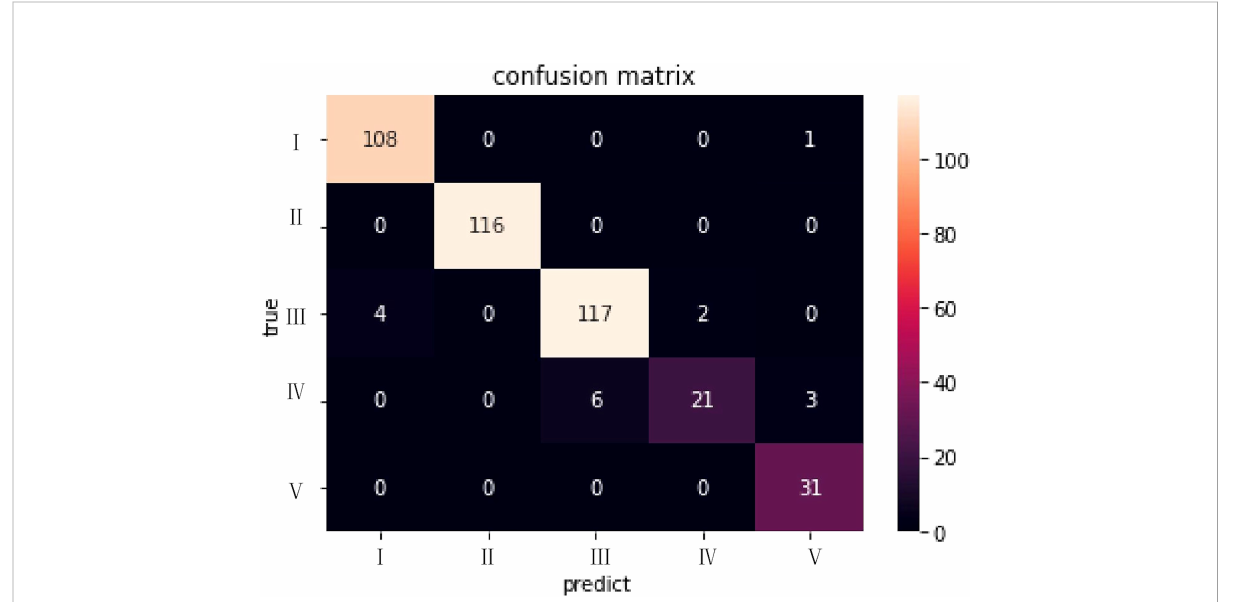
FIGURE 4 The confusion matrix for the XGBoost model in the dataset of CT with/without contrast. The abscissa represented the predicted results and the ordinate the actual results.